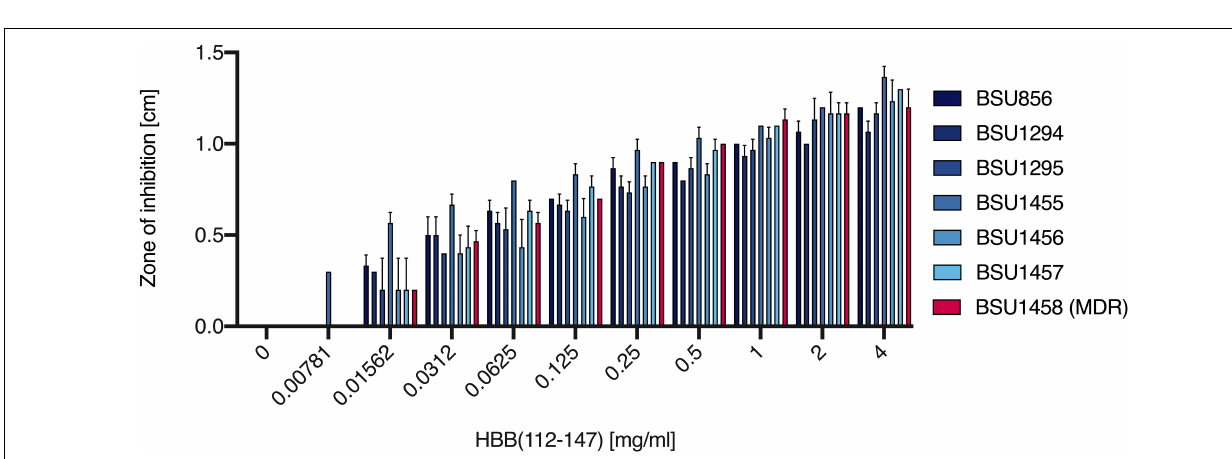
FIGURE 6 | Antibacterial activity of HBB(112–147) against clinical Pseudomonas aeruginosa isolates. The effect of indicated concentrations of HBB(112–147) was tested against several clinical isolates of Pseudomonas aeruginosa in a radial diffusion assay. BSU1458 (red) is a carbapenem/multi-drug resistant P. aeruginosa isolate. Depicted are inhibition zones in cm observed in a radial diffusion assay ( n = 3, mean values + SD).